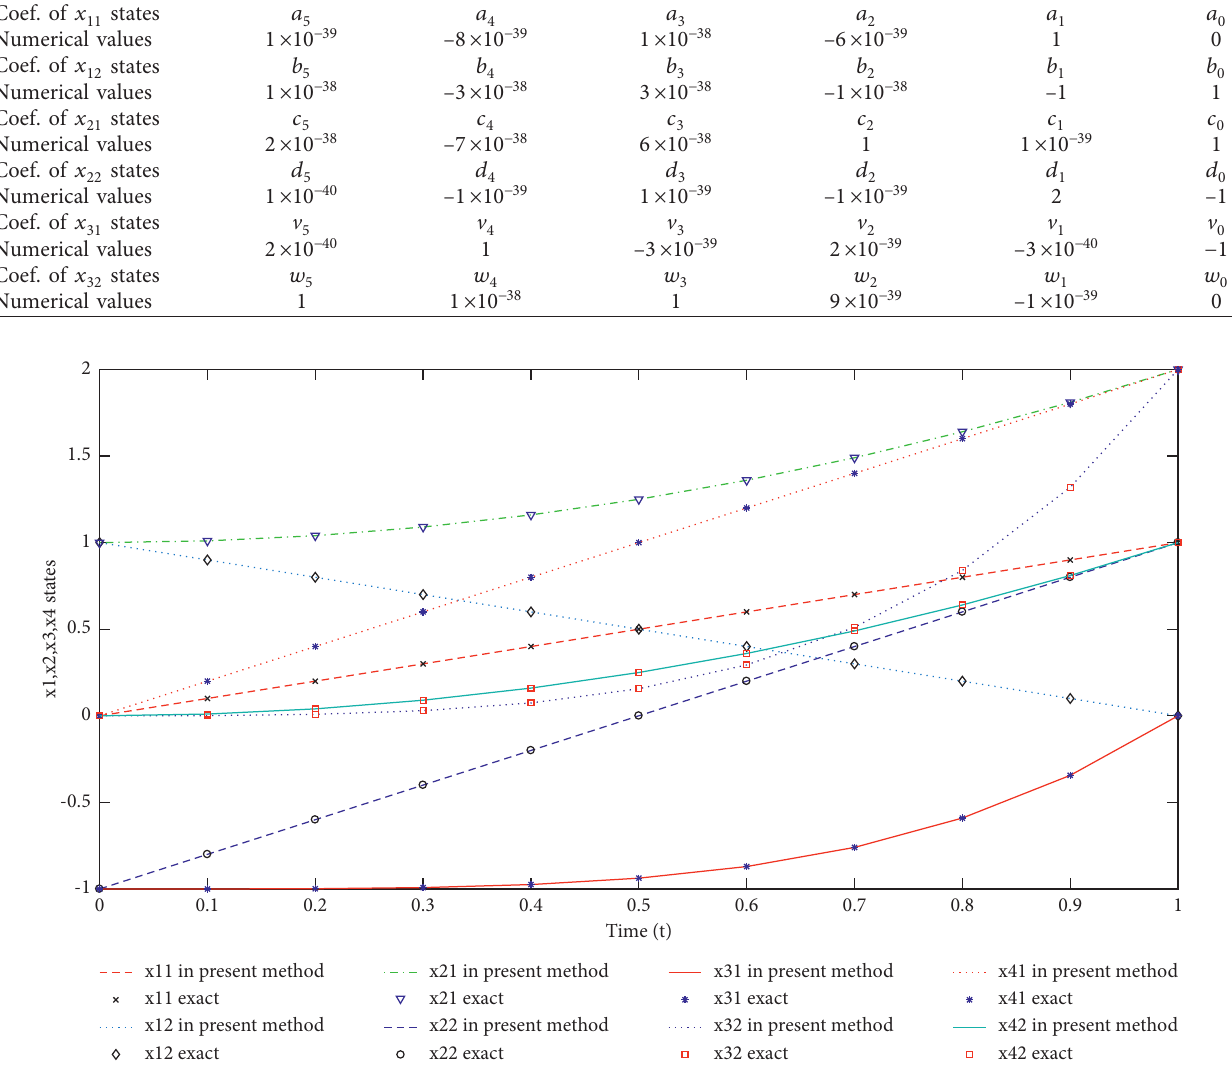
( t ) ,x ( t ) , and x ( t ) . 1 2 3